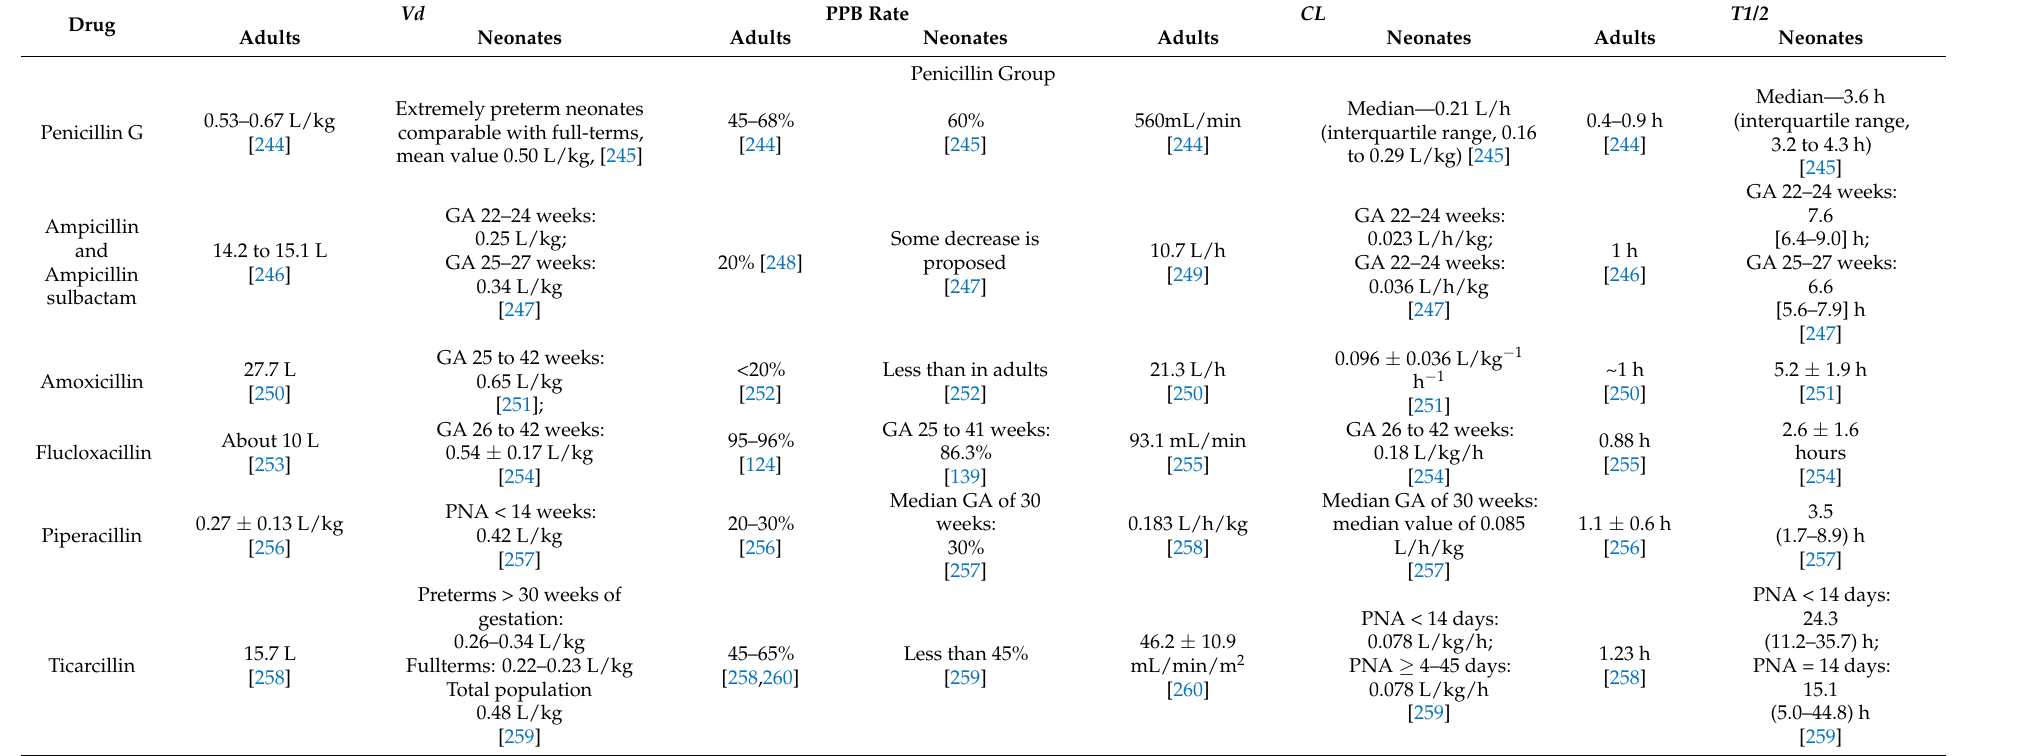
Table 9. PPB, Vd and CL of antibiotics in neonates and